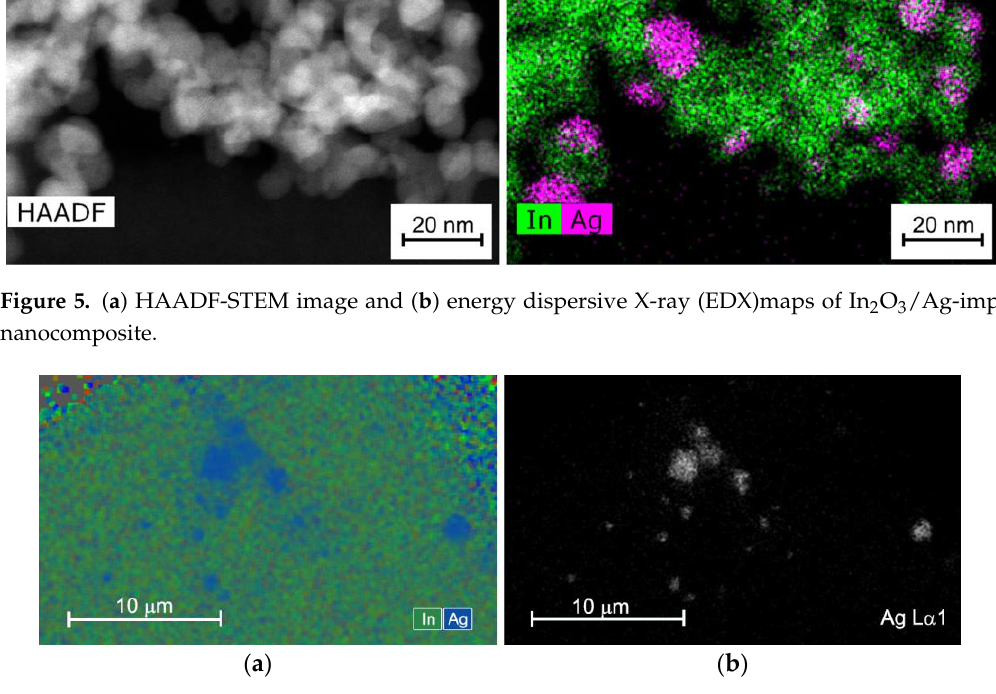
Figure 6. ( a ) EDX map of element distribution in In 2 O 3 /Ag-UV nanocomposite. ( b ) EDX map of corresponding Ag L α1 signal.